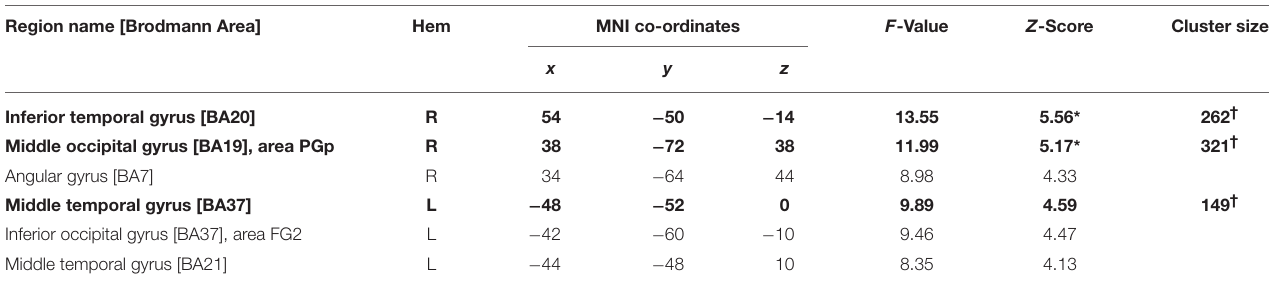
TABLE 2B | Summary of results for the main effect of condition in Patient